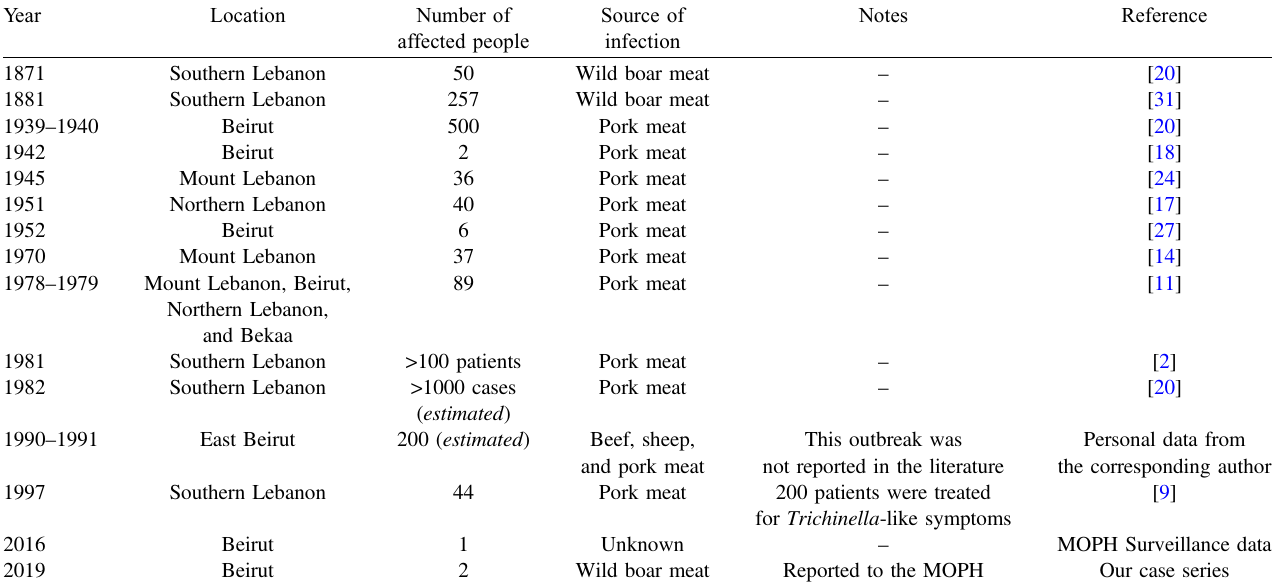
Table 2. Trichinellosis outbreaks in